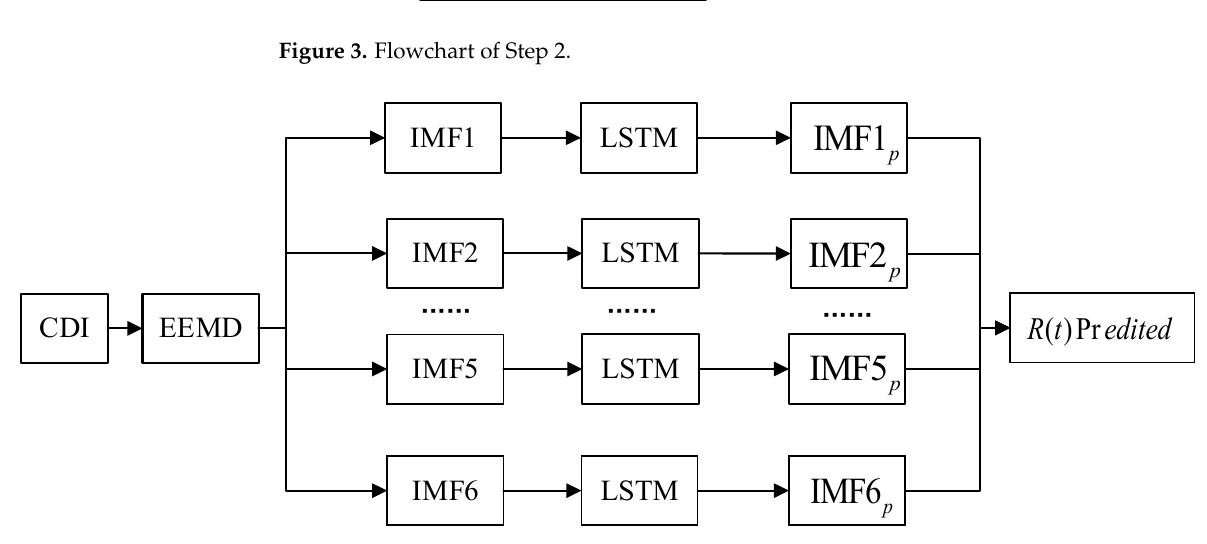
Figure 3. Flowchart of Step 2.